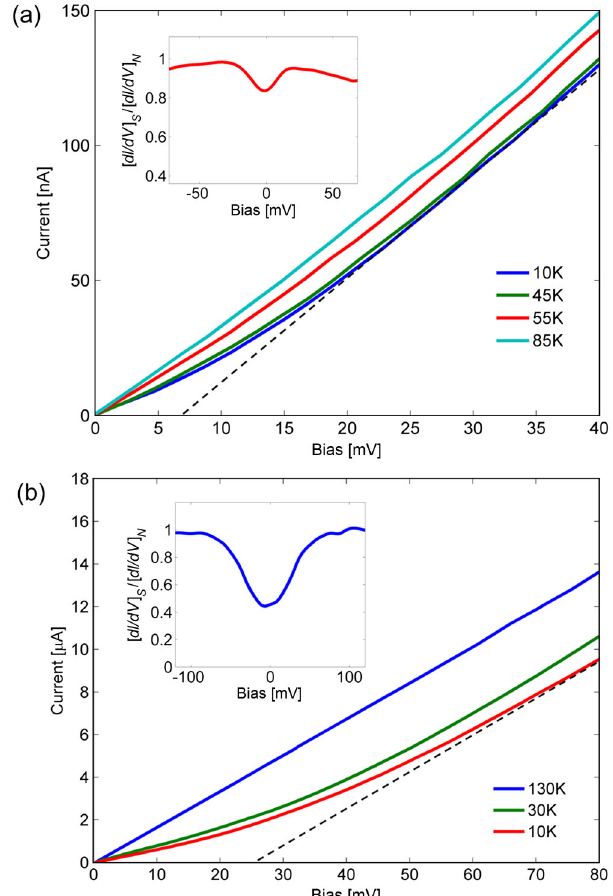
FIG. 5. (a) Measured DC I-V characteristics for the Bi-2212/ graphite junction at various temperatures. The dashed line in- dicates a linear I-V dependence coinciding with the 10-K mea- surement at a higher bias to indicate the excess voltage. The inset is the measured differential conductance ½ dI=dV (cid:4) S at 10 K, divided by the normal-state conductance ½ dI=dV (cid:4) N for the Bi- 2212/graphite junction. (b) Measured DC I-V characteristics for the Bi - 2212 = Bi 2 Te 3 junction at various temperatures. The dashed line indicates a linear I-V dependence coinciding with the 10-K measurement at higher bias to indicate the excess voltage. The inset is the measured differential conductance ½ dI=dV (cid:4) S at 10 K, divided by the normal-state conductance Bi - 2212 = Bi Te ½ dI=dV (cid:4) N for the 2 3